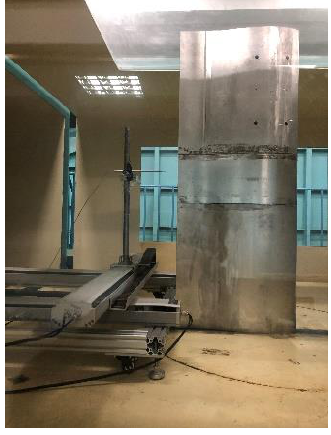
Figure 5. Wake measurements.